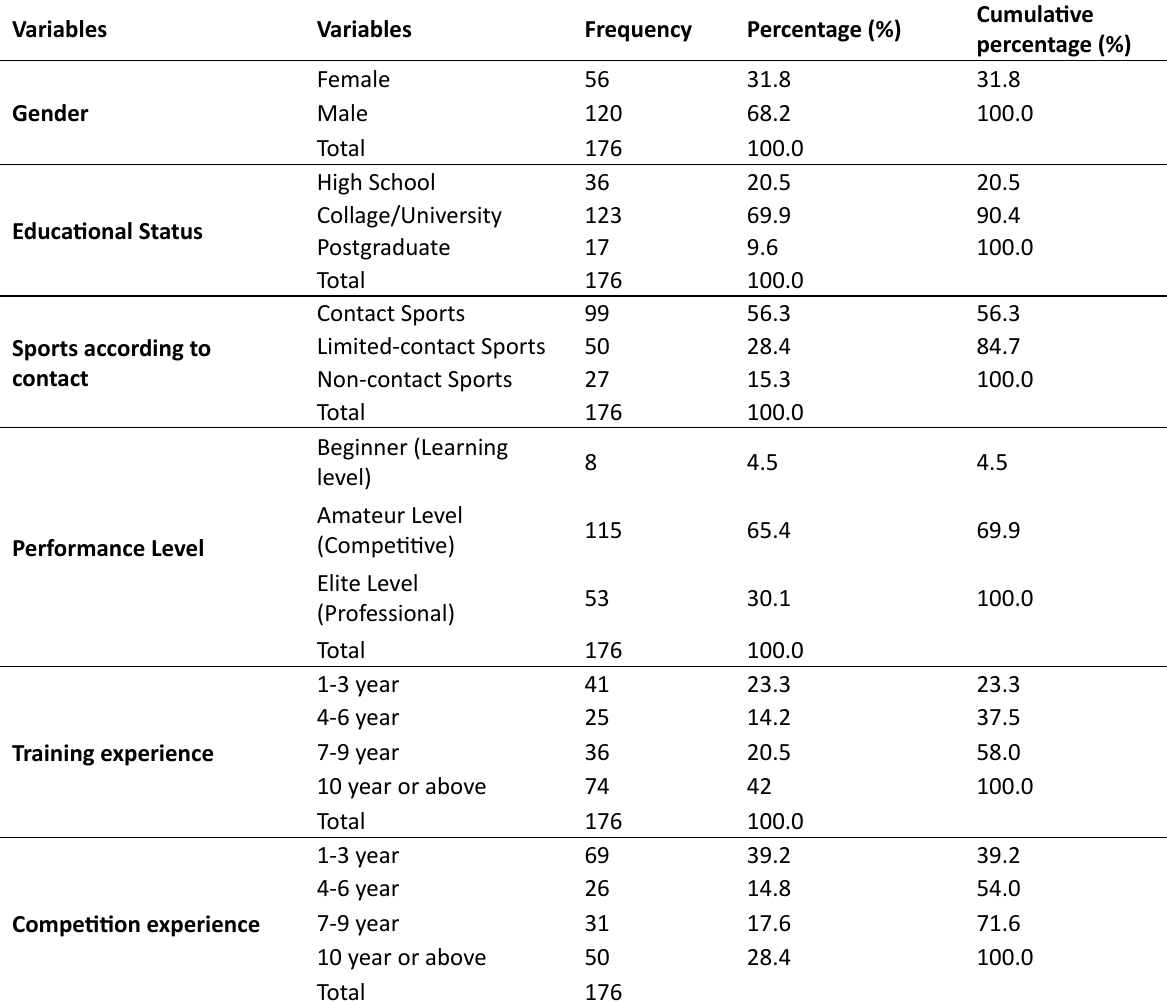
Table 1. Demographic characteristics of the athletes